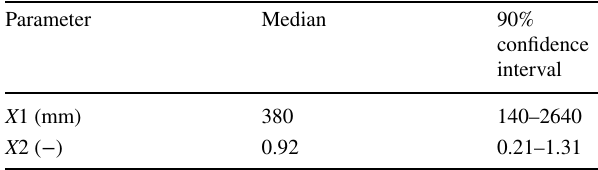
Table 1 GR2M model parameters value (Bouanani et al. 2015) Parameter